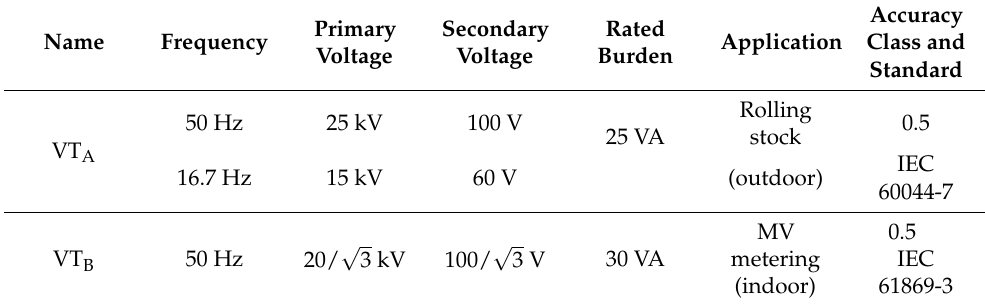
Table 3. Main features of VTs under